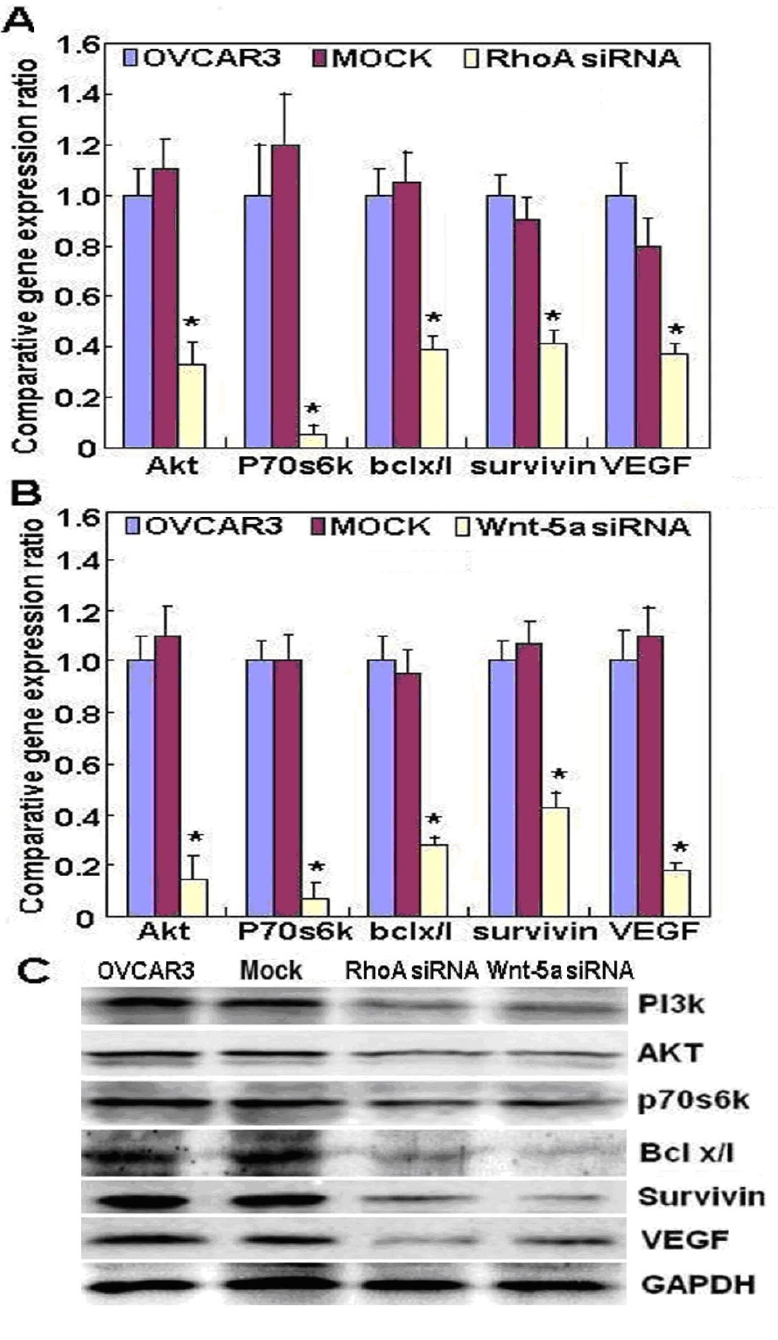
Figure 4. OVCAR3 cell mRNA and protein expression profiles after RhoA or Wnt-5a knockdown. ( A – C ) OVCAR3 cells transfected with RhoA siRNA or Wnt-5a siRNA expressed significantly lower levels of Akt, Bcl-xL, VEGF, p70S6k, and survivin mRNA ( A and B ) and protein ( C ) in comparison with NC and mock-transfected cells. * p <